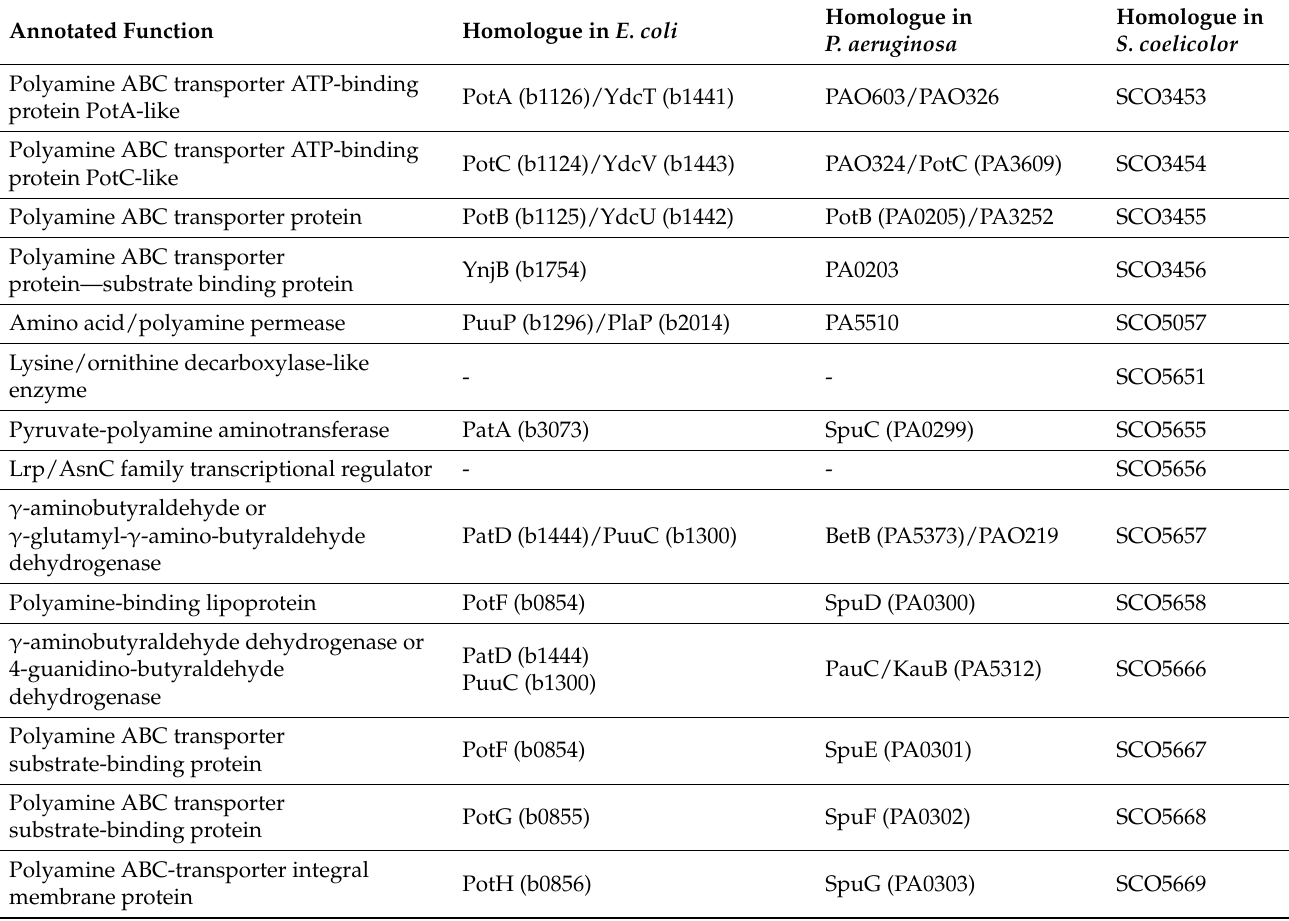
Table 1. List of proteins involved in polyamine utilization in E. coli , P. aeruginosa , and S. coelicolor